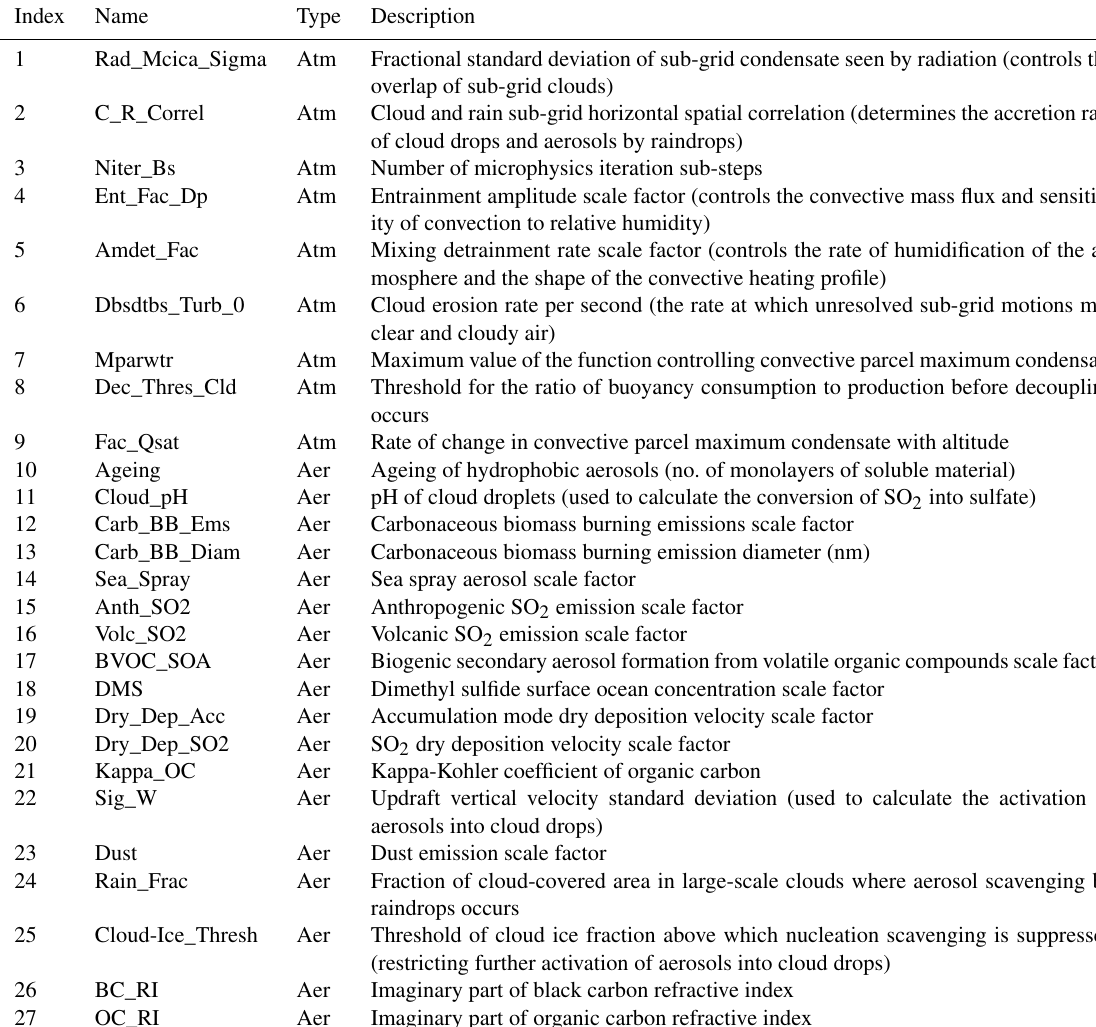
Table 1. The 27 host model and aerosol parameters included in the PPE. Further details are provided in a separate publication (Regayre et al.,